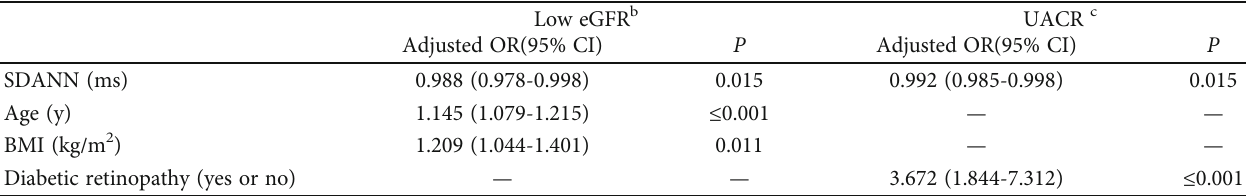
Table 4: Results of binary logistic regression for the independent correlations between renal function and HRV parameters and di ff erent clinical characteristics a